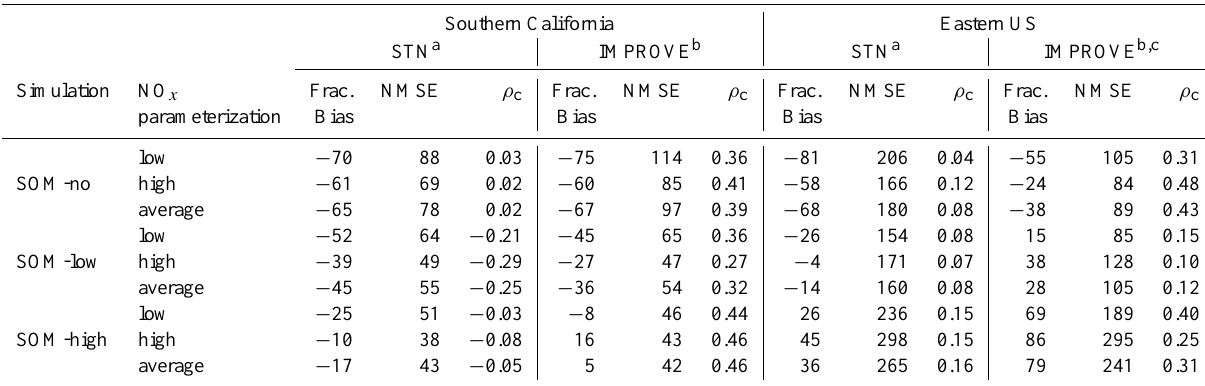
Figure 3. 14-day averaged f SOA , the ratio between SOA and total OA concentrations, for (top panels, a , b , c ) SoCAB and (bottom panels, d , e , f ) the eastern US for the (a, d) SOM-no, (b, e) SOM-low and (c, f) SOM-high simulations. Table 1. Model performance metrics determined for the three simulation groupings (SOM-no, SOM-low and SOM-high) for the low-NO x , high-NO x and average parameterizations for STN and IMPROVE sites in SoCAB and the eastern US. Fractional bias is calculated as 2 ( C OA,sim - C OA,obs )/ ( C OA,sim + C OA,obs ) and NMSE as abs[( C OA,sim - C OA,obs ) 2 / ( C OA,sim × C OA,obs ) ], and the reported values are the averages over all data points as percentages. Note that a negative fractional bias indicates observed [SOA] >simulated [SOA], i.e. that the simulations are underpredicting. ρ c are the concordance correlation coefficients from Eq.